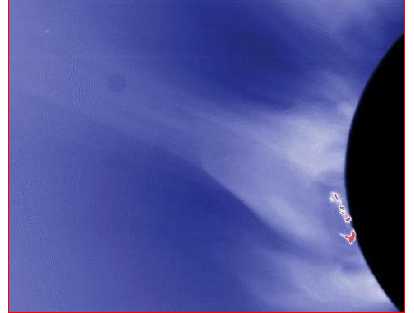
Figure 15: Helmet streamer during a solar eclipse. Slow wind leaks into the interplanetary space along the flanks of this coronal structure. Image reproduced from